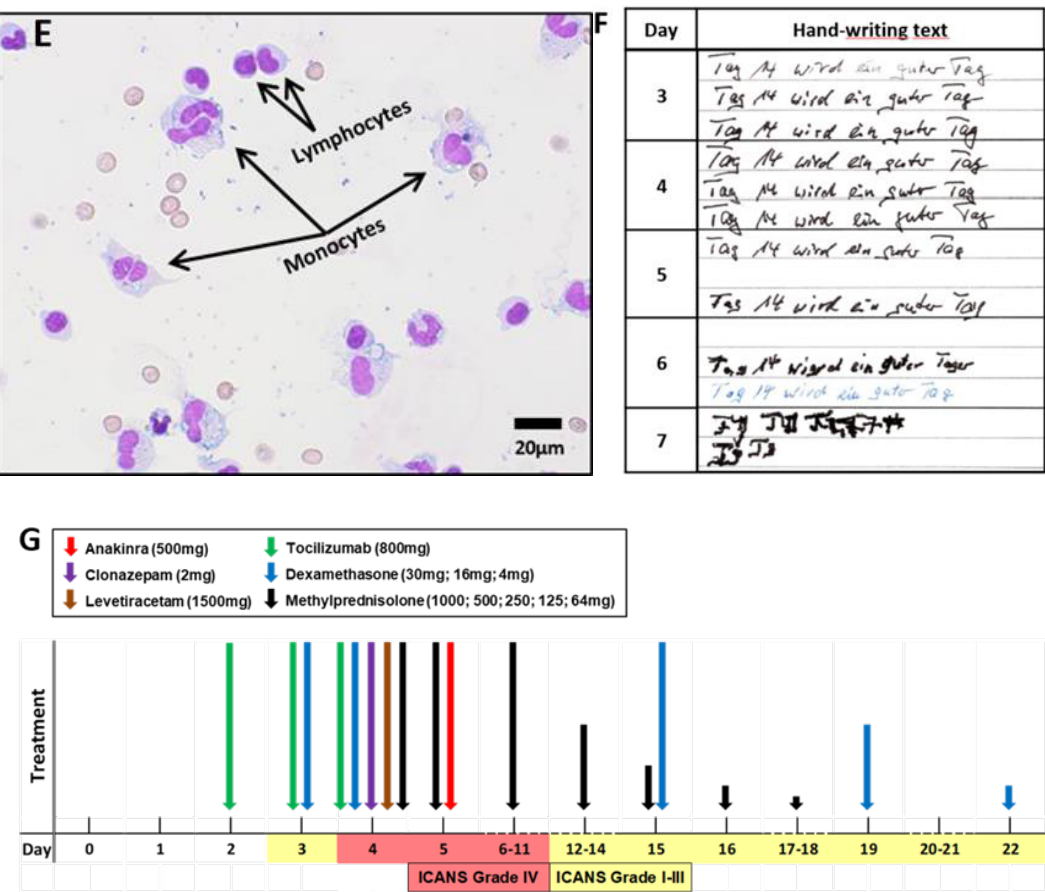
Figure 2. ( A ) CARTs were monitored in peripheral blood (PB) mononuclear cell (PBMC) samples of axi-cel treated patients #7 and #8. Additionally, CART frequency of patient #8 in the cerebrospinal fluid (CSF) was assessed on days 10 and 22 after treatment. CSF of patient #7 was not analyzed. Determined peak copy numbers are included within the graph. Mean Ct values from qPCR were used for copy number assessment using SCG-DP-PCR. ( B ) Peak CART frequencies in patients #7 and #8 who developed immune effector cell-associated neurotoxicity syndrome (ICANS) grade IV after axi-cel treatment were compared to mean peak CART frequencies of 18 axi-cel patients (grade 0–III). Mean Ct values from qPCR were used for copy number assessment using SCG-DP-PCR. Result for the low-grade ICANS (grade < III) group is represented as mean ± SD. ( C , D ) Assessment of clinical inflammatory markers ferritin, C-reactive protein (CRP), interleukin (IL)-1β, IL-6, IL-10 and IL-1 receptor antagonist (RA) in the PB of patient #8. Normal ranges of ferritin, CRP, IL-1β, IL-6 and IL-10 are indicated by green dotted lines. Normal range of IL-1RA (180–1300 pg/mL) is not included in the figure. ( E ) Microphotograph of hematoxylin and eosin stained cells (50x magnification) in the CSF of patient #8 at day 10 after CARTs. Morphologically, larger macrophages and smaller lymphocytes were detected in a 60:40 ratio. ( F ) Handwriting sample. On days 5 up to 7 after axi-cel treatment, the handwriting of the patient with high-grade ICANS was significantly impaired. ( G ) Treatment of ICANS in patient #8. Arrows correspond to administered ICANS treatment compounds (doses per day). Besides steroids, anti-convulsive treatment with levetiracetam and clonazepam as well as anti-IL-1 treatment with anakinra were administered. Initially, the patient was also treated with the IL-6-receptor blocker tocilizumab due to concomitant cytokine release syndrome (CRS). Tapering of methylprednisolone and dexamethasone is indicated by shortened arrows.